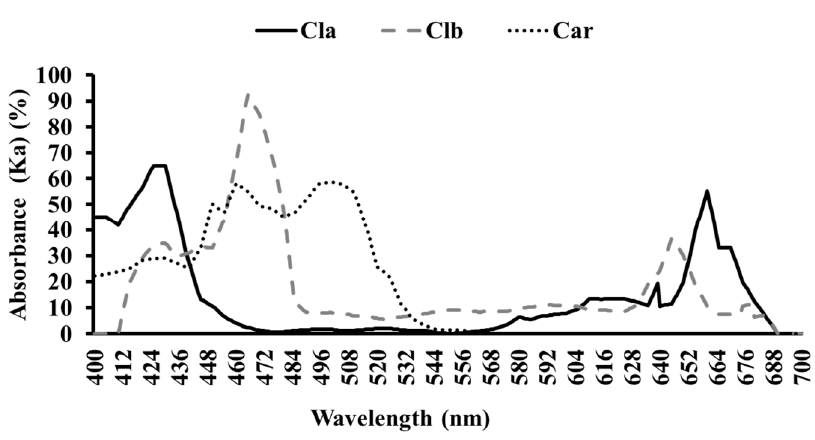
Figure 4. Percentage of energy absorbed (Ka) by pigments (car, chla, chlb) according to each wavelength.